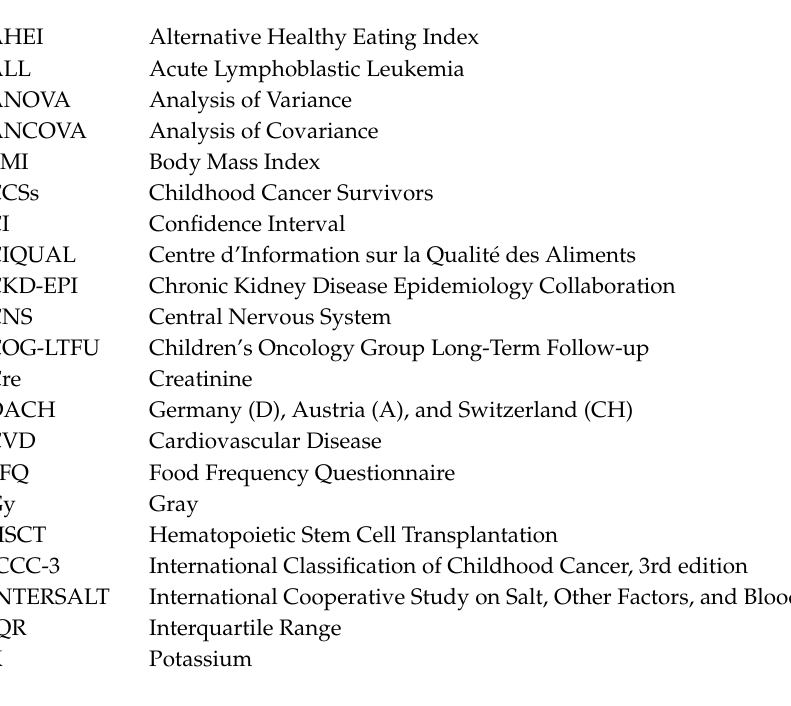
Table S1: Scoring method and mean scores (95% CI) of components of the modified Alternate Healthy Eating Table S2: Sociodemographic and lifestyle characteristics of adult childhood cancer survivors by participants and nonparticipants to the SCCSS-Nutrition study, Table S3: Clinical characteristics of adult childhood cancer survivors by participants and nonparticipants to the SCCSS-Nutrition study, Table S4: Dietary intake based on self-reported food frequency questionnaire (FFQ) data of adult childhood cancer survivors by participants to the SCCSS-Nutrition study, Table S5: Sodium (Na) and potassium (K) intake based on food frequency questionnaire (FFQ) data of adult childhood cancer survivors (CCSs) by language region within Switzerland, Figure S1: Response rates in the Swiss Childhood Cancer Survivor Study (SCCSS)-Nutrition study, Figure 2A.: Self-reported cardiovascular related medical history questions in French assessed within the Swiss Childhood Cancer Survivor Study(SCCSS)-Nutrition Study, Figure 2B: Self-reported cardiovascular related medical history questions in German assessed within the Swiss Childhood Cancer Survivor Study (SCCSS)-Nutrition